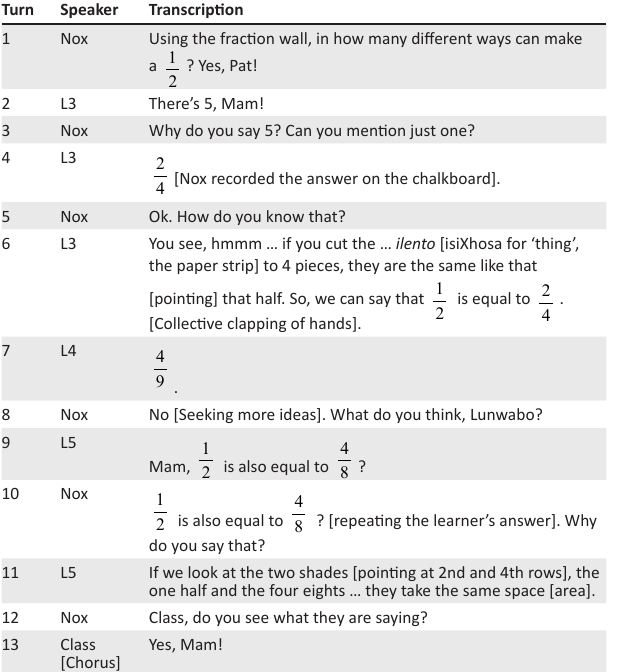
TABLE 2: Nox’s instruction moves from conviction to seeking generalisation. Turn